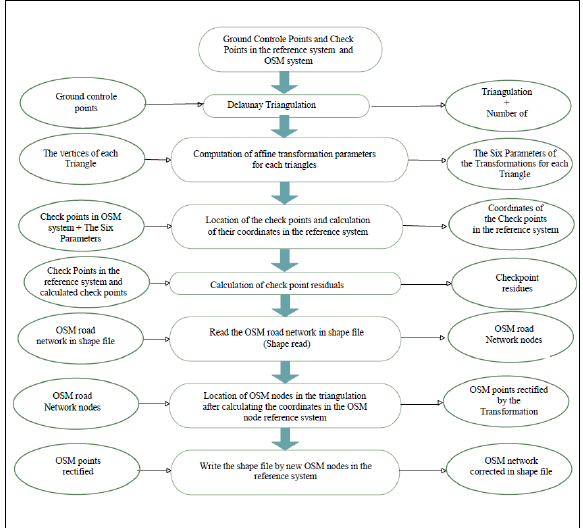
Figure 4. Framework of Triangular Affine Transformation (TAT)